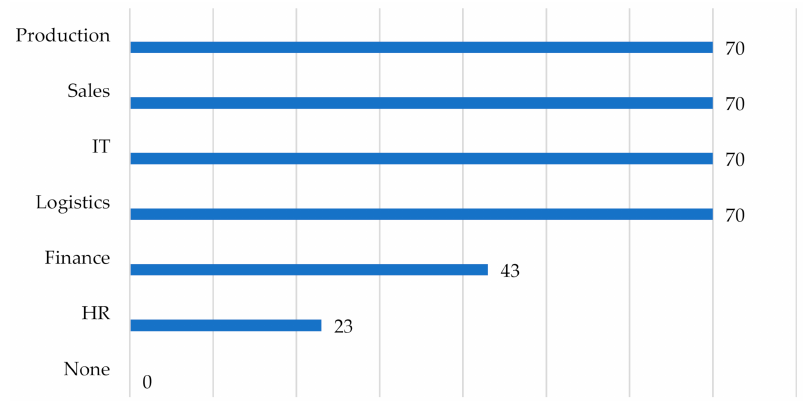
Figure 8. Internal processes where there is a need to apply the pillars of Industry